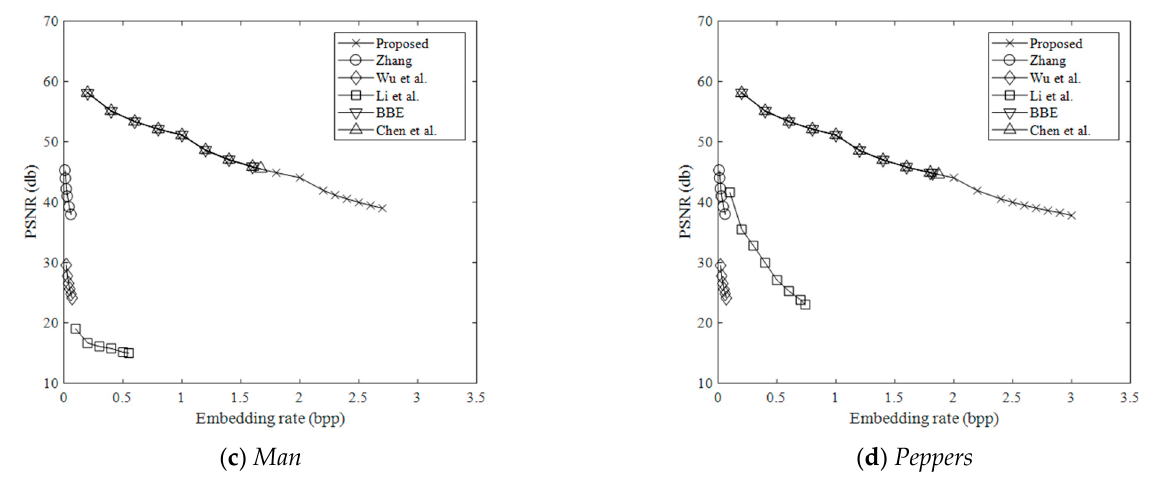
Figure 9. Comparison of the marked decrypted image quality ( Crowd , Lena , Man , Peppers ).